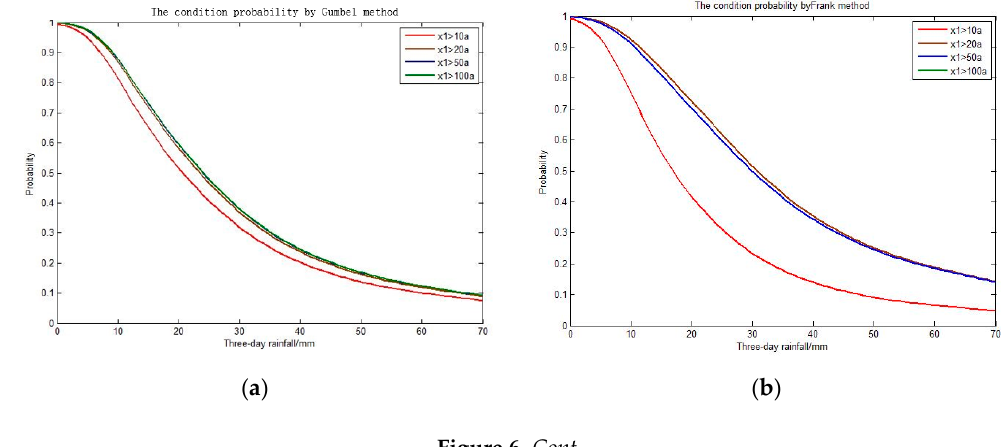
Table 8. The upper tail dependence coefficients for Gumbel copulas.